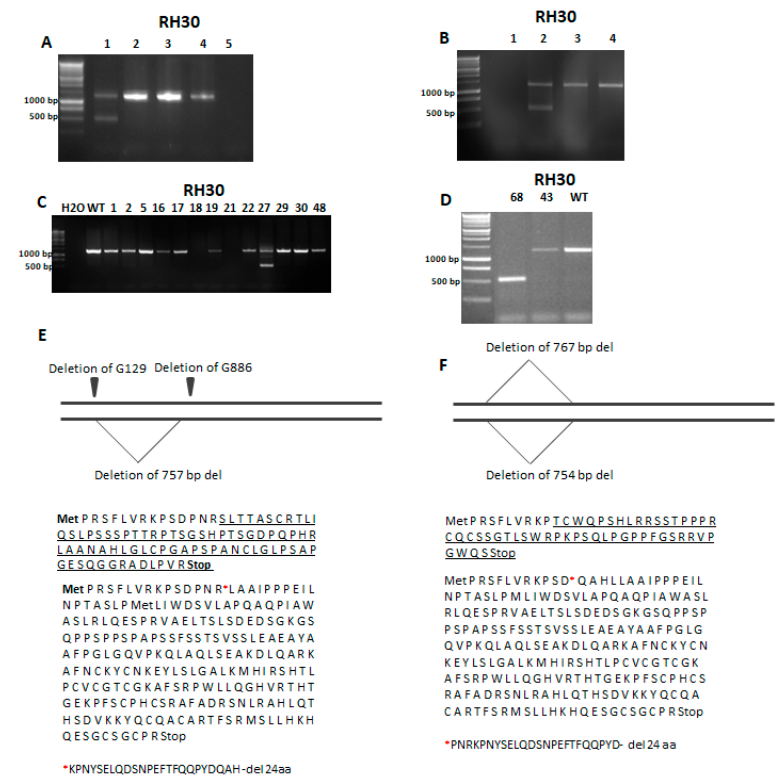
Figure 2. Identification of RH30 clones with a SNAI1 knockout (KO) after genome editing with TALEN and CRISPR / Cas9 nucleases. ( A ) PCR verification of the activity of CRISPR / Cas9 system (1—RH30 mix after transfection, 2,3,4—RH30 WT, 5—H 2 O). ( B ) Investigation of TALEN activity with PCR using gDNA (1—H 2 O, 2—RH30 mix after transfection, 3—RH30 ctrl, 4—RH30 WT). ( C ) Screening of the clones after CRISPR / Cas9 genome editing using PCR with gDNA. One clone (no. 27) gave two